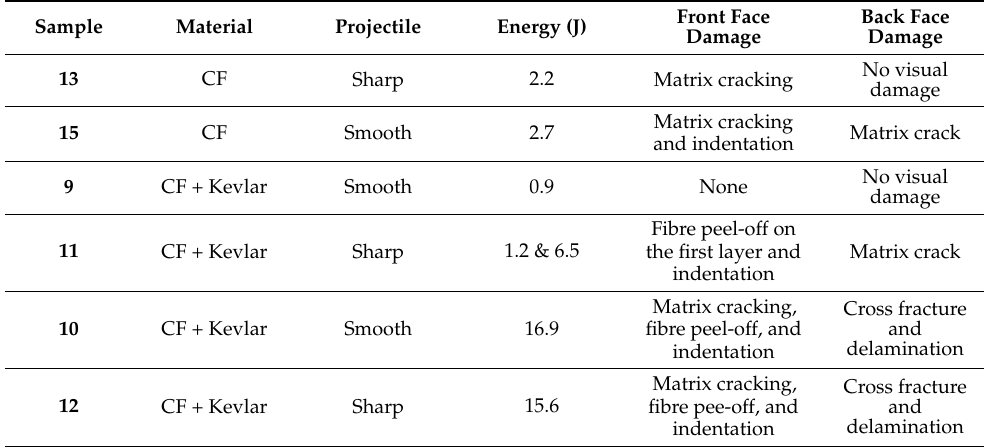
Table 4. Summary of damage observed on the composite panels under orthogonal